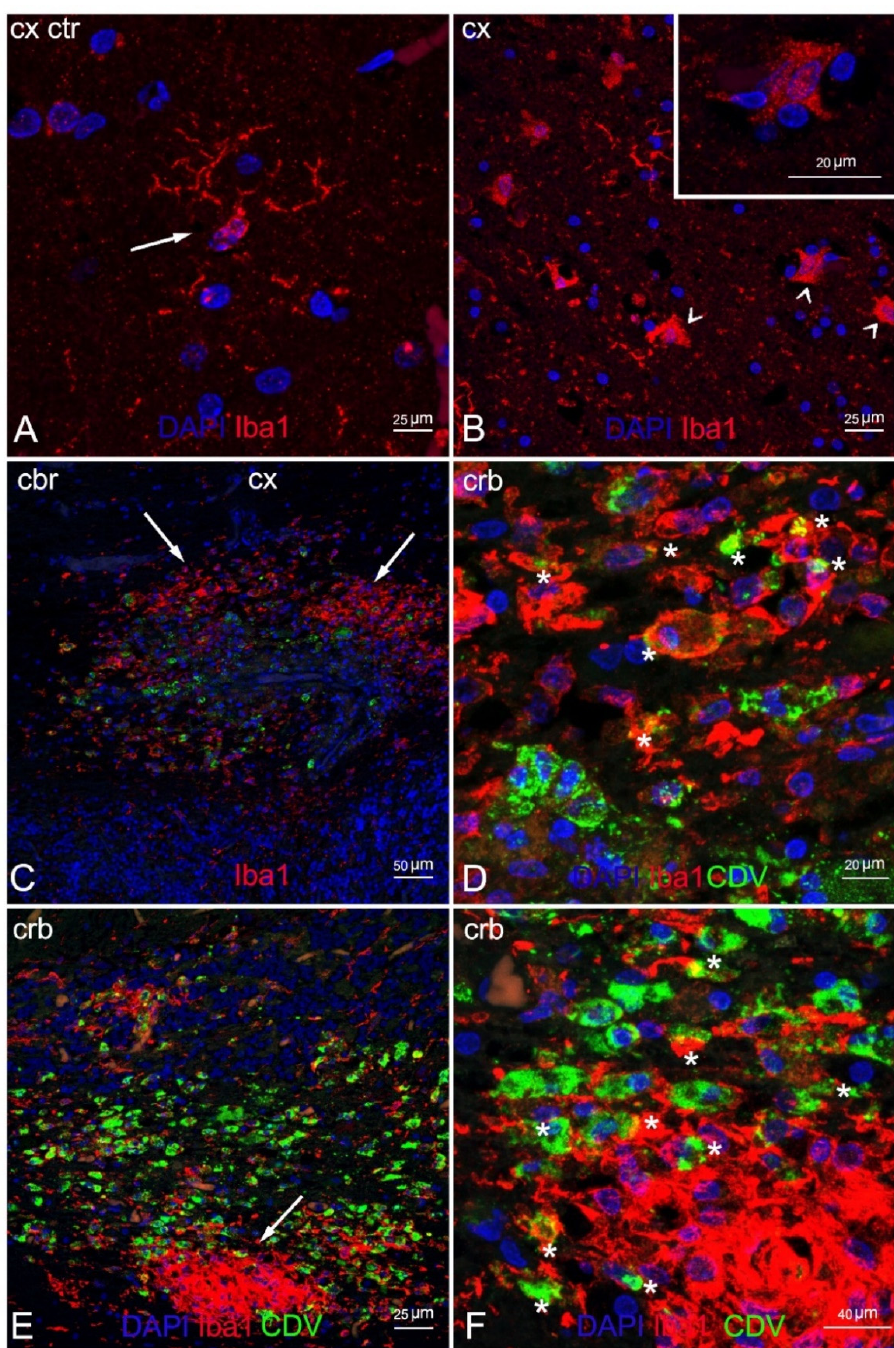
Figure 6. Characterization of demyelinated areas by means of double IF for microglia and DMV. ( A ) Cerebral cortex (negative control). Microglia in normal condition (resting state) (arrow). Note the typical ramified morphology characterizing these cells in healthy tissues. ( B ) Cerebral cortex (ID 28). Reactive microglia in demyelinated white matter (arrowhead). Inset: magnification of reactive microglia. ( C ) Cerebellar cortex (ID 10). Microgliosis in white matter (arrow) infected with DMV. ( D ) Magnification of image 4C. Marked co-localization of microglia and DMV (asterisks). ( E ) Cerebellar cortex (ID 10). Microglial nodule (arrow) positive for DMV. ( F ) Magnification of image 6E. Co-localization of microglia and DMV (asterisks) in the periphery of the nodule. Legend: Cx, cortex; Crb, cerebellum; Ctr, negative control; DAPI, 4,6-diamidino-2-phenylindole; CDV, canine distemper